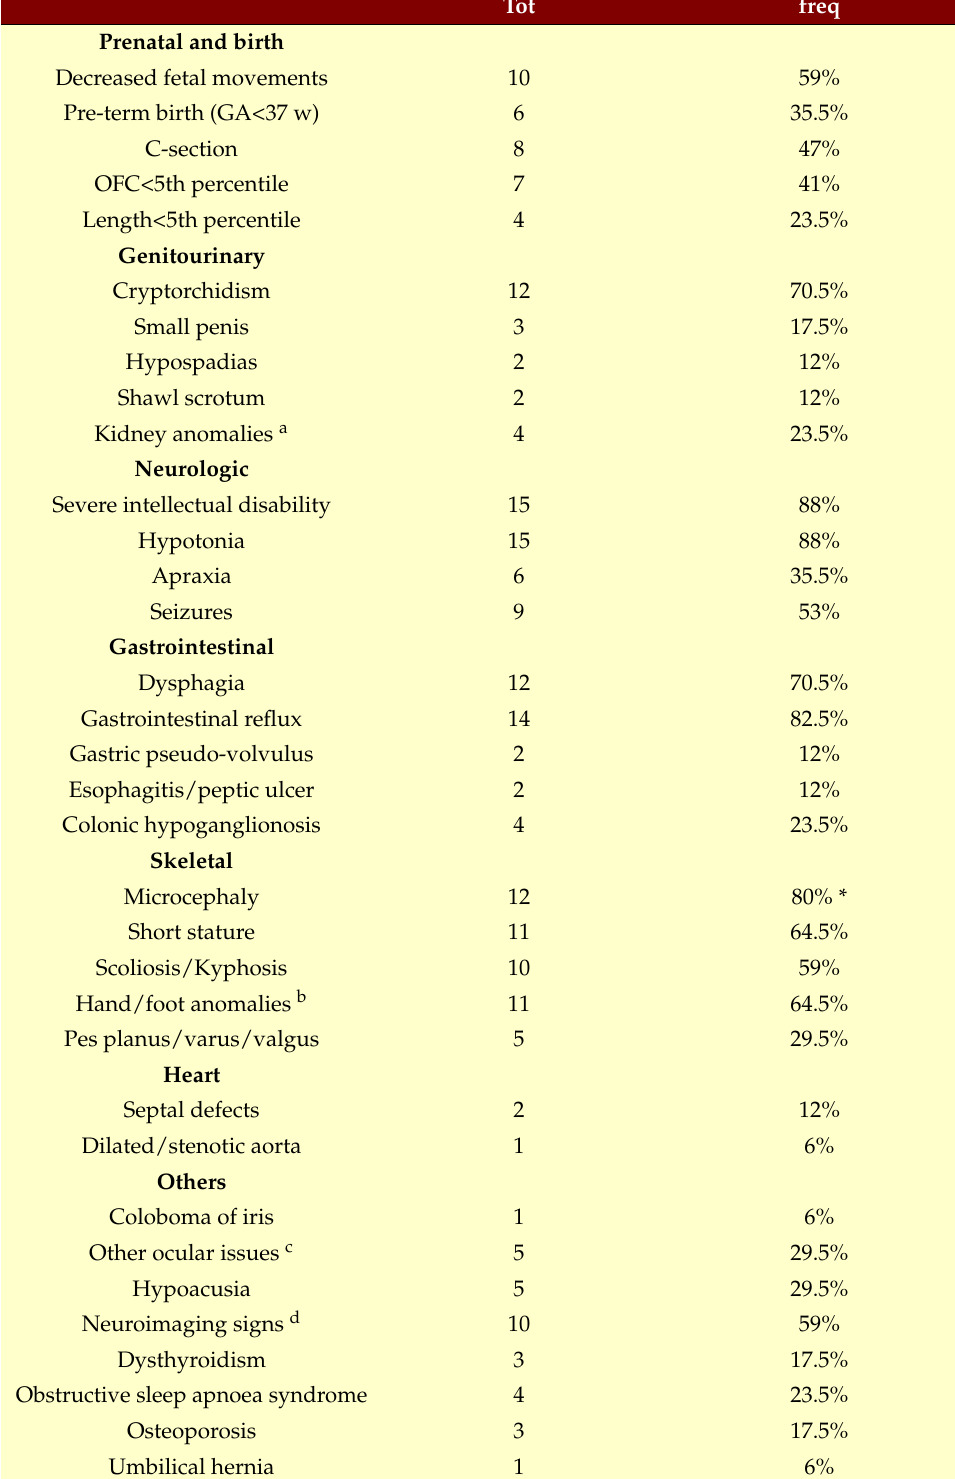
Table 3. Detailed clinical features and their frequency in the overall population of patients. Tot